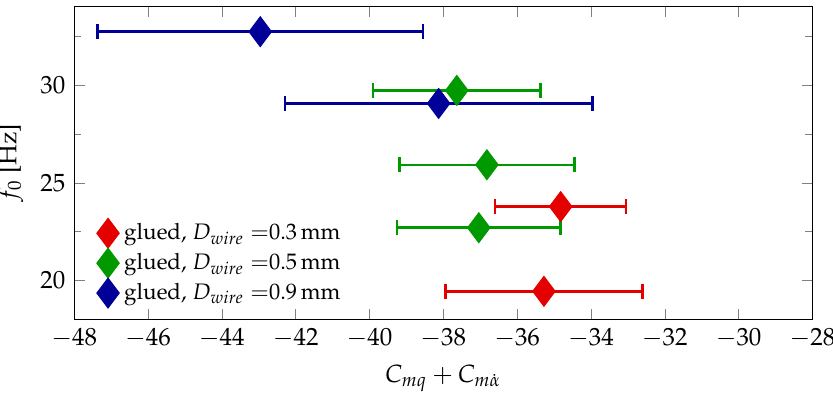
Figure 16. Oscillation frequency over C mq + C m ˙ α at Mach 0.8 without correction calculated with the wire damping model.